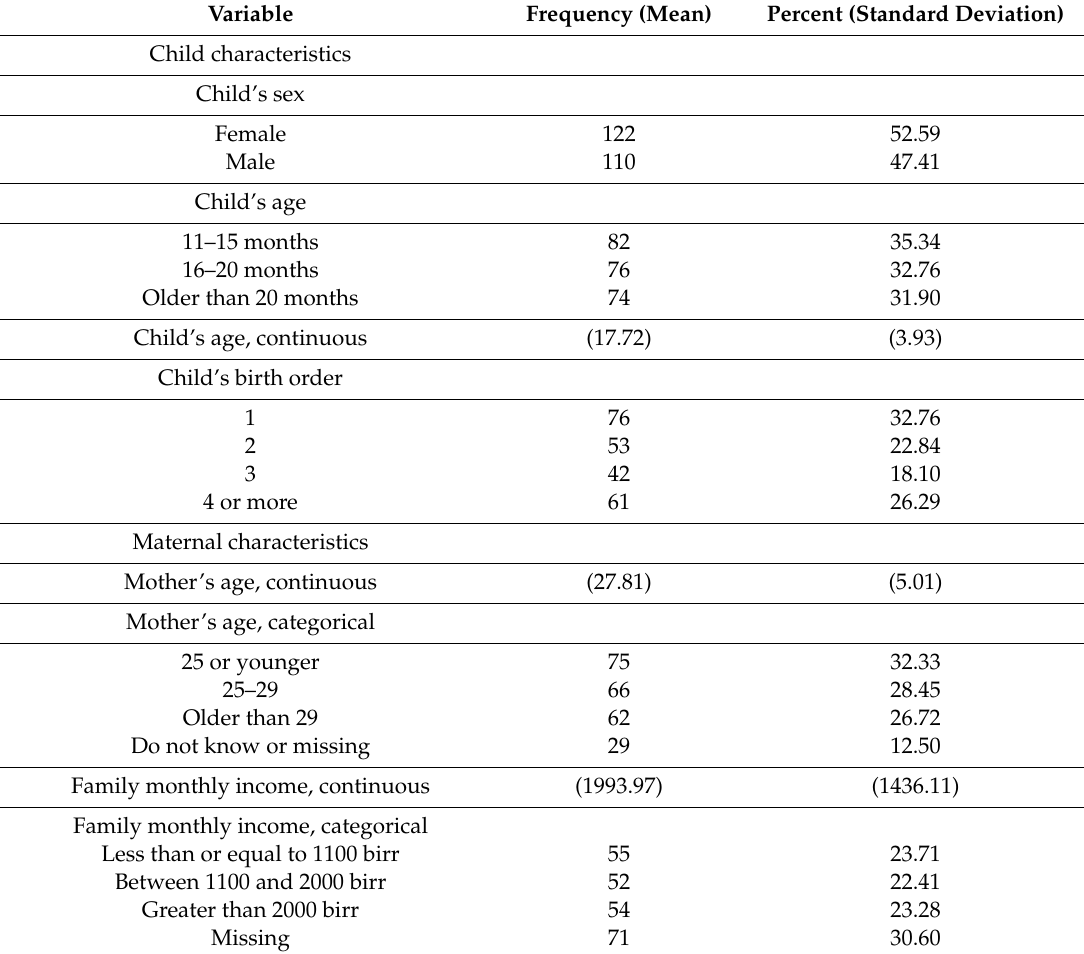
Table 2. Descriptive statistics of sample of women and children included in accuracy analysis (n =